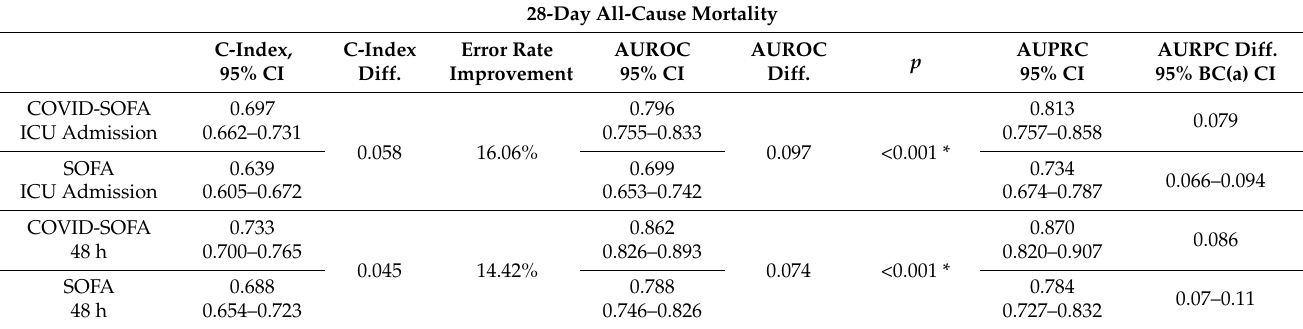
Table 2. A comparative analysis of COVID-SOFA score vs. SOFA score discriminative ability.